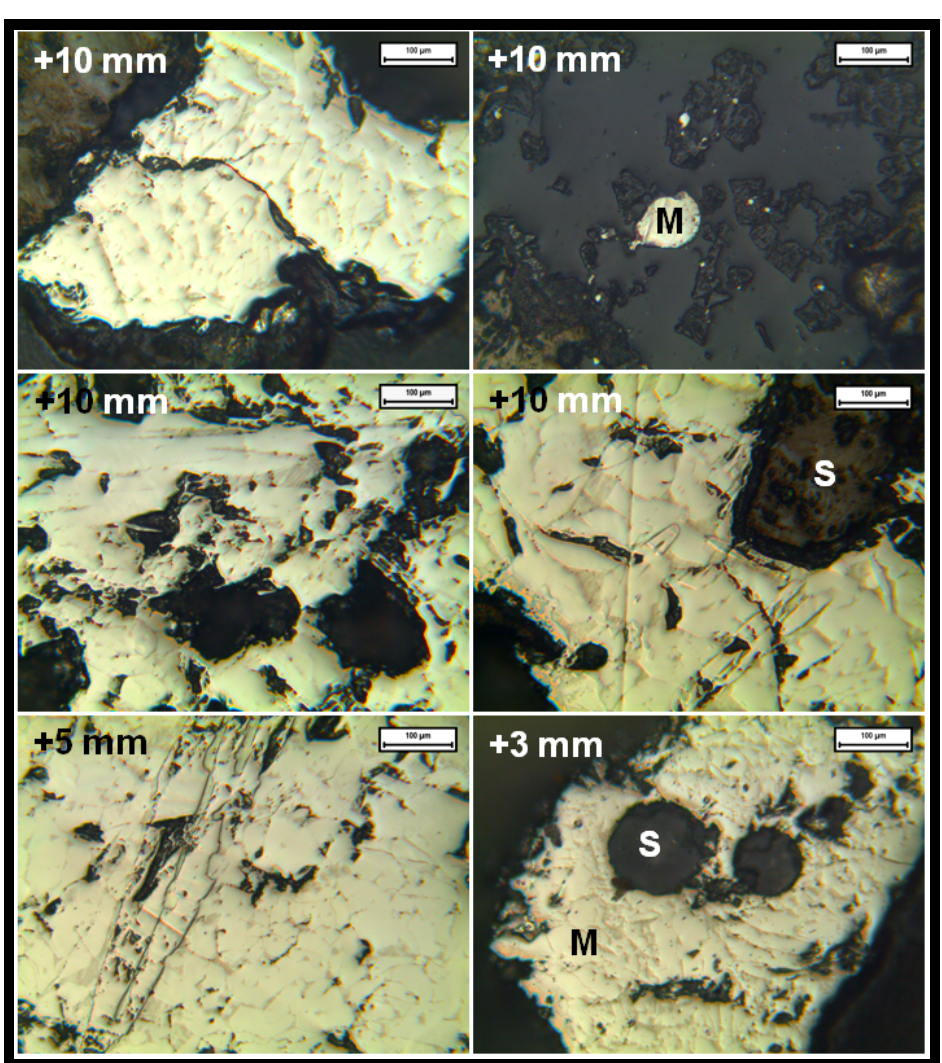
Figure 1. Optical microscopy analysis of particles of ferrochrome slag.